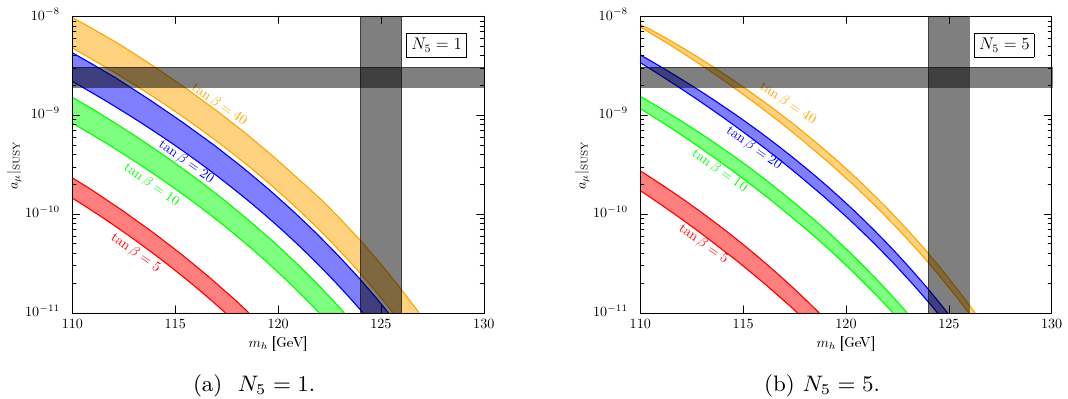
Figure 1. The predicted Higgs mass and a µ in the minimal GMSB. For each value of tan β , we vary F Z /A Z and M mess ∈ [10 4 , 10 16 ] GeV. The vertical and the horizontal shaded regions correspond to the observed values of the Higgs boson mass and a , respectively. For the Higgs mass constraint, µ we include the theoretical uncertainty of the prediction of the Higgs